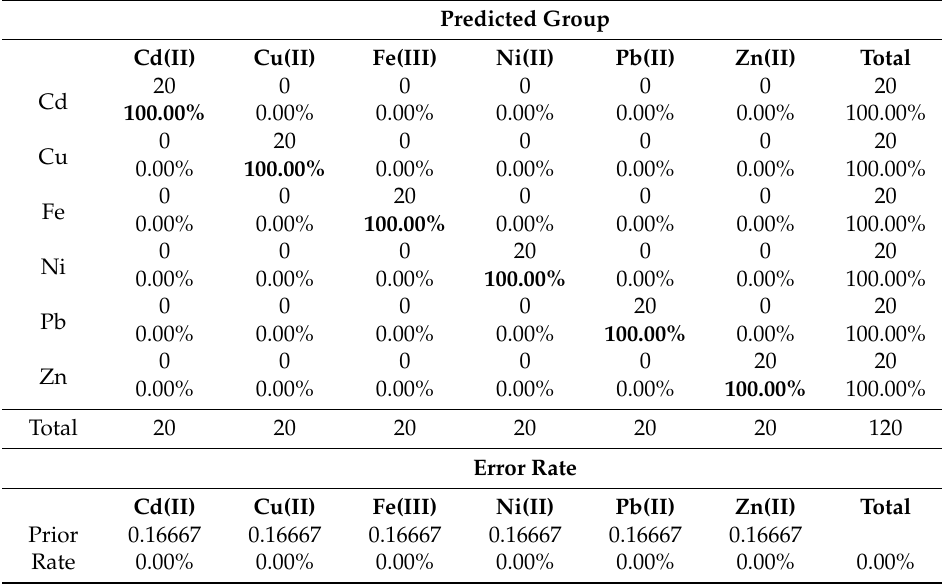
Table 4. Classification counts and error rates of different metallic ions obtained after processing and analyzing the fitted parameter of transmittance spectra (obtained with UV-VIS spectrometer) by the linear discriminant analysis method.